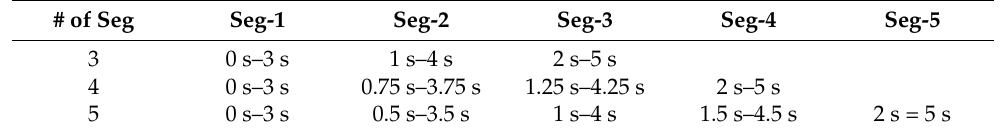
Table 4. Distance Fusion Segments.